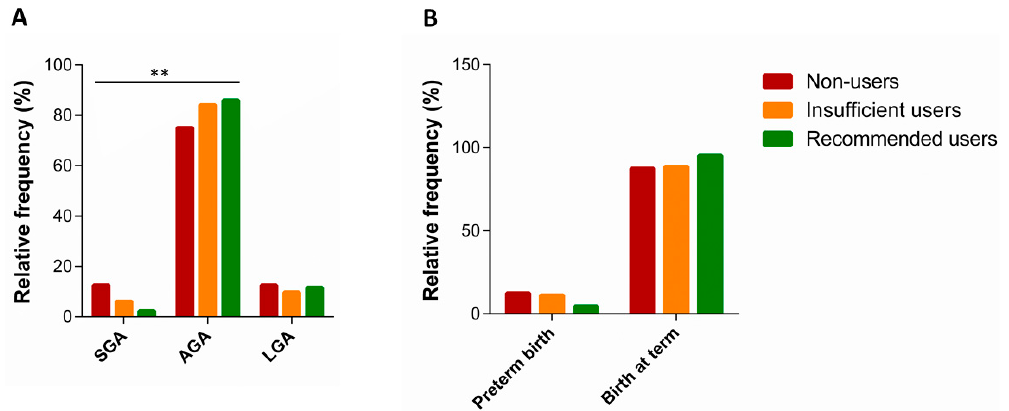
Figure 3. Neonatal adverse outcomes and folic acid supplement use among women with folate deficiency. ( A ) Panel A shows the distribution of small for gestational age (SGA), adequate for gestational age (AGA) and large for gestational age (LGA) infants. ( B ) Panel B shows the distribution of preterm and at term birth. ** p -value < 0.01.